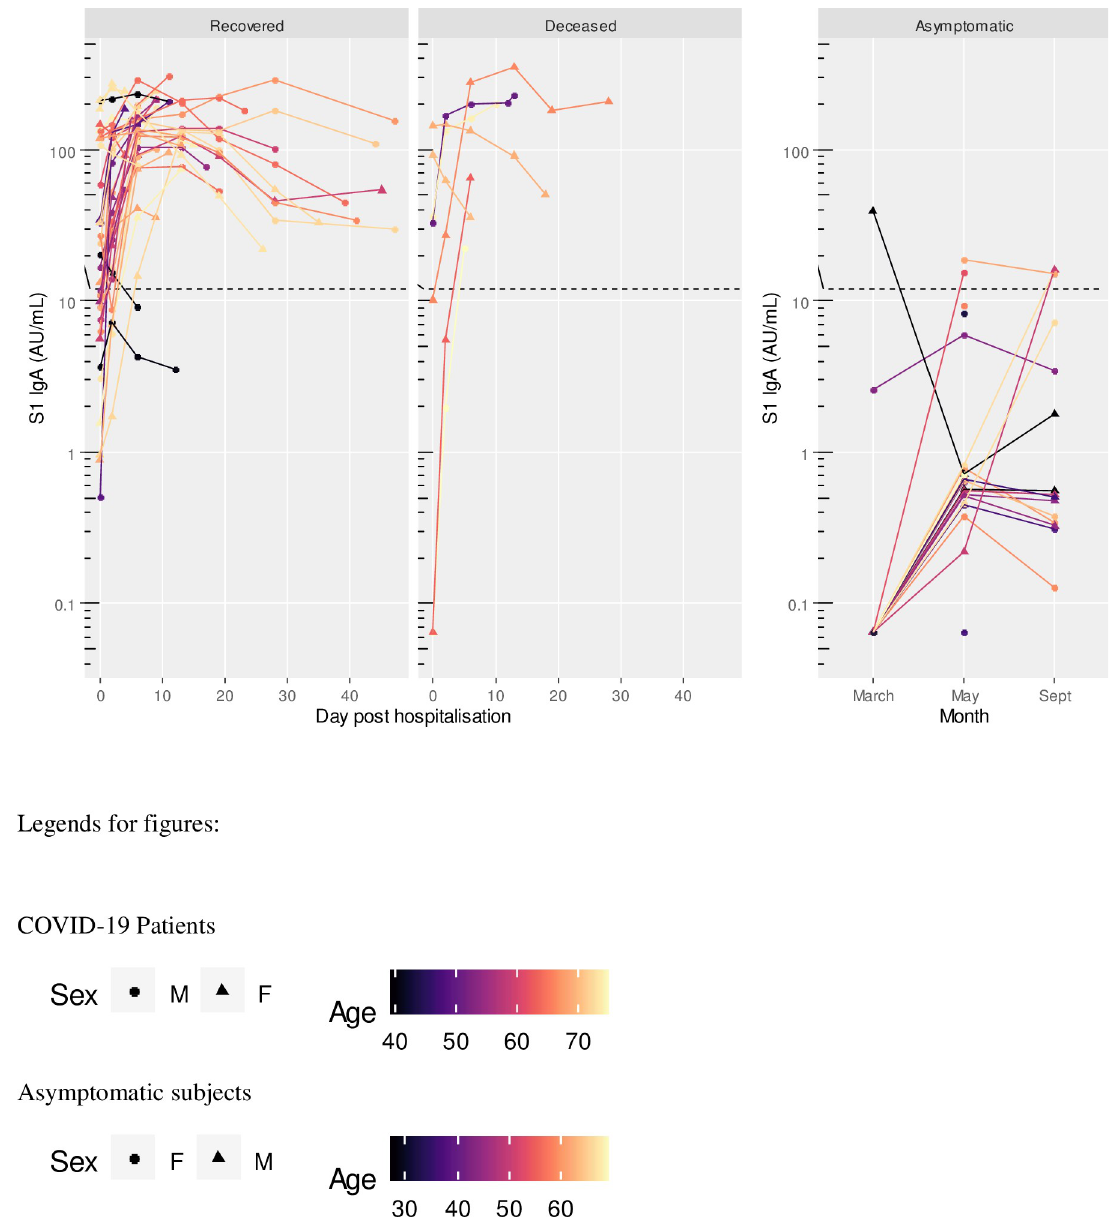
Fig 2. S1 IgA titres in COVID-19 patients (recovered and deceased) and asymptomatic subjects. Black dashed line indicates positivity threshold at 12